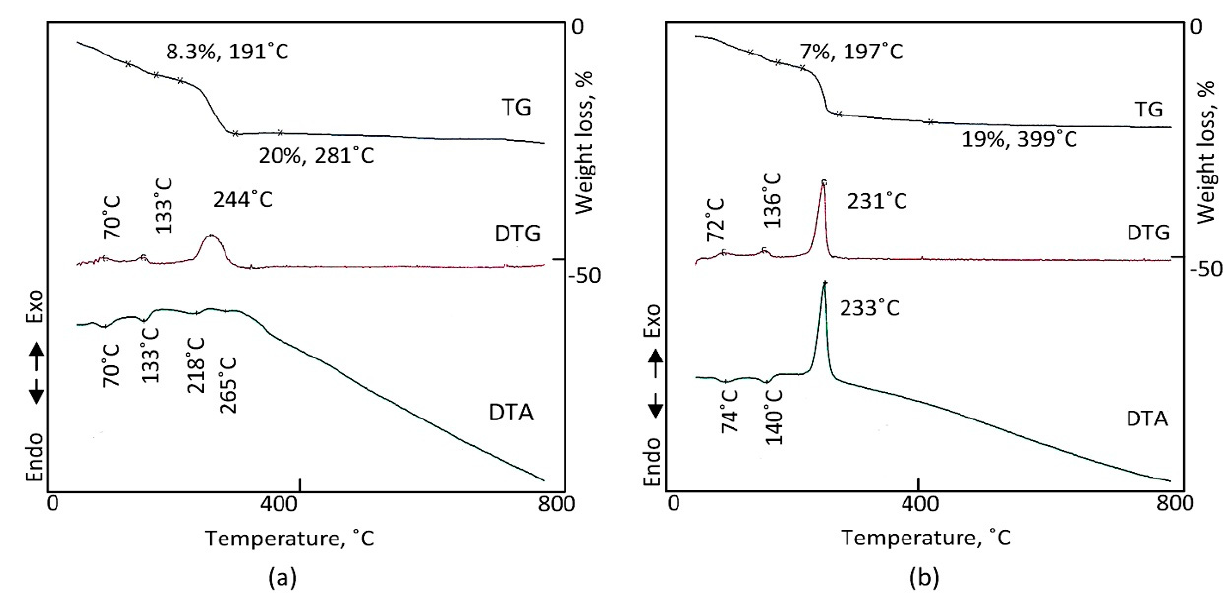
Figure 8. Thermal analyses of CSHDS in presence of: ( a ) nitrogen gas and ( b ) air. In the first stage, the water was lost through three steps [38]. It was found that 4.6 wt.%, 7 wt.% and 8.3 wt.% were lost at 107 ◦ C, 150 ◦ C and 191 ◦ C, respectively. These losses were confirmed by DTG and DTA. DTA showed two endothermic peaks at 70 ◦ C and 133 ◦ C. It means that the water molecules are bonded in the lattice by two different species—nitrate and cyanate anions [14,15]. In the second stage, 11.7 wt.% was lost, indicating the removal of the interlayered anions at 281 ◦ C. The thermal decomposition of the interlayered anions was confirmed by two endothermic peaks at 218 ◦ C and 265 ◦ C in the DTA curve. It means that there are two anions in the lattice of